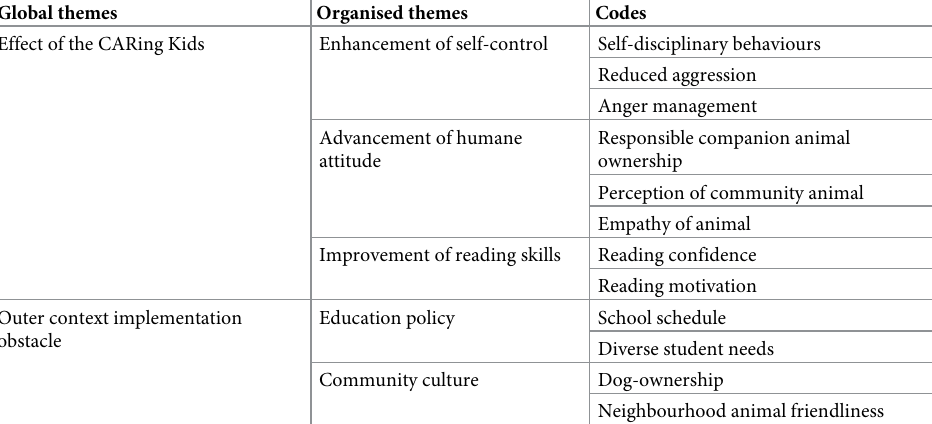
Table 5. Themes that emerged from qualitative